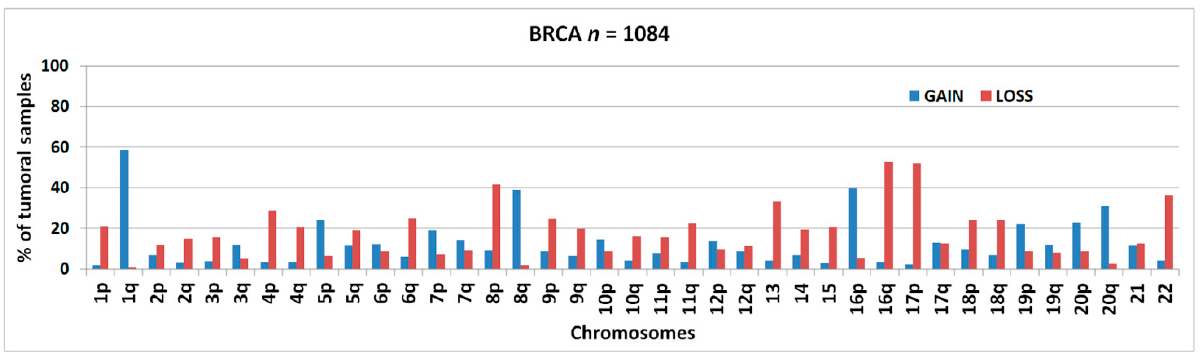
Figure 1. Percentage of samples bearing chromosomal arm-level gains or losses in 1084 breast invasive carcinoma (BRCA) samples.